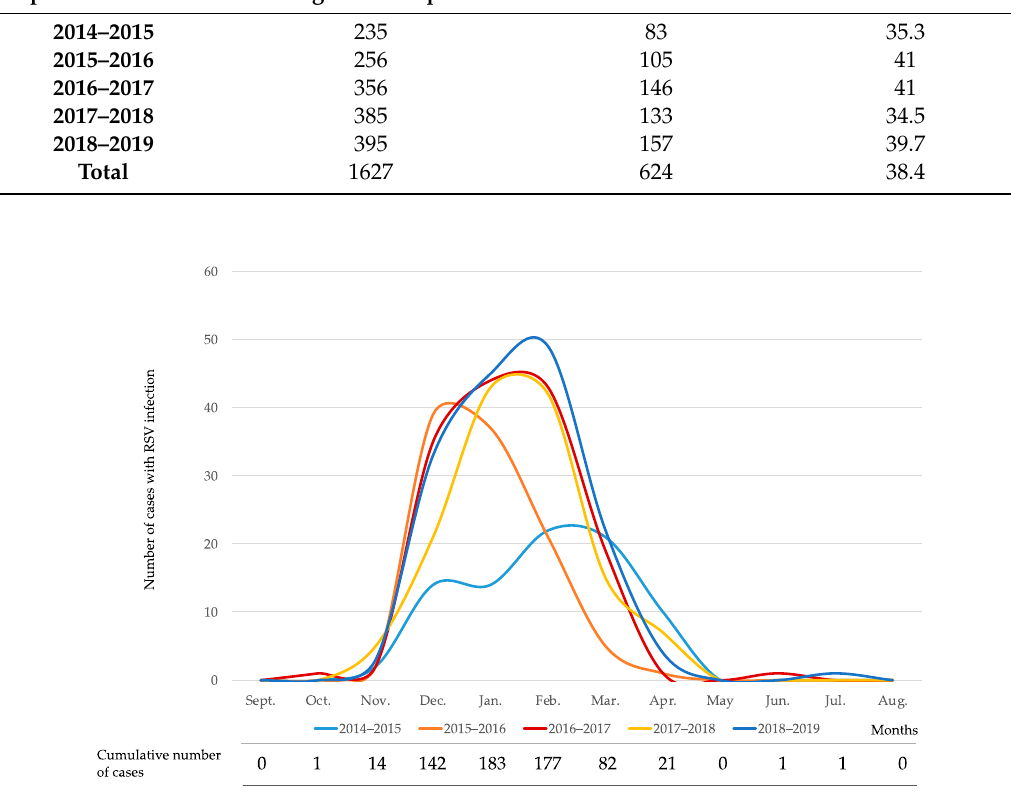
Figure 1. Seasonal trend of respiratory syncytial virus (RSV) infection in Tuscany in each single study year and cumulative number of cases in the 5-year study